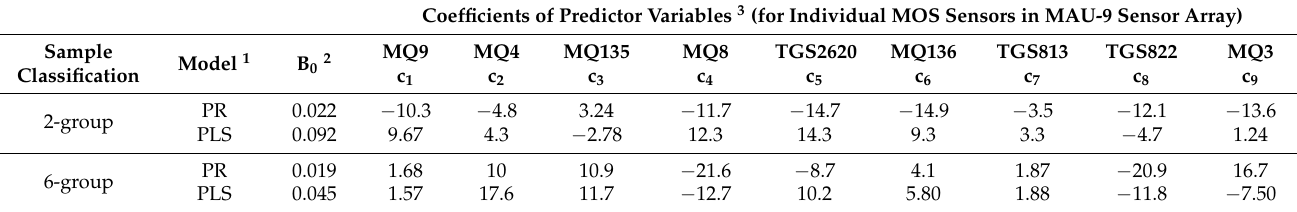
Table 2. The regression coefficients estimated by principal regression and partial least square models. Coefficients of Predictor Variables 3 (for Individual MOS Sensors in MAU-9 Sensor Array) Sample